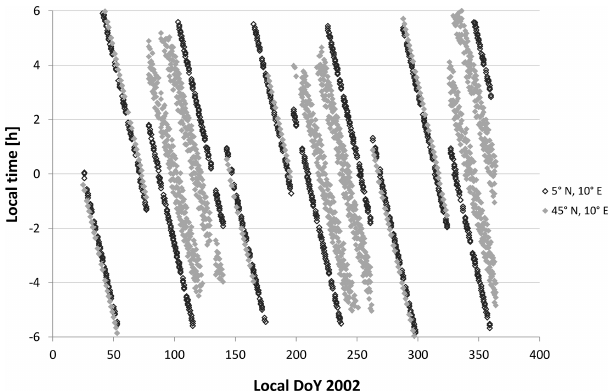
Figure 3. Local overpass time of TIMED for the grid cells at 5 ◦ N, 10 ◦ E (dark grey), and 45 ◦ N, 10 ◦ E (light grey), for the year 2002 between 18:00 and 06:00LT. A negative local time means that the respective profile was recorded before midnight ( − 2LT = 22:00LT, − 4LT = 20:00LT, − 6LT = 18:00LT). Daily averages are not com- puted; this plot shows the individual measurements (959 for 5 ◦ N and 1626 for 45 ◦